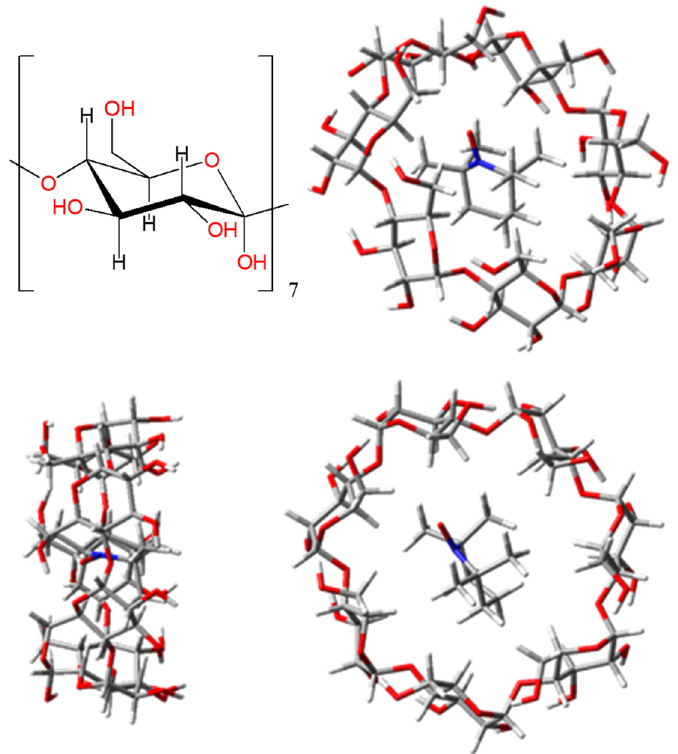
Figure 14. Chemical scheme of β -cyclodextrin ( β -CD) host molecule and different views of optimized host-guest complex with TEMPO radical, TEMPO@ β -CD. The color code is the same as in Figure 13.